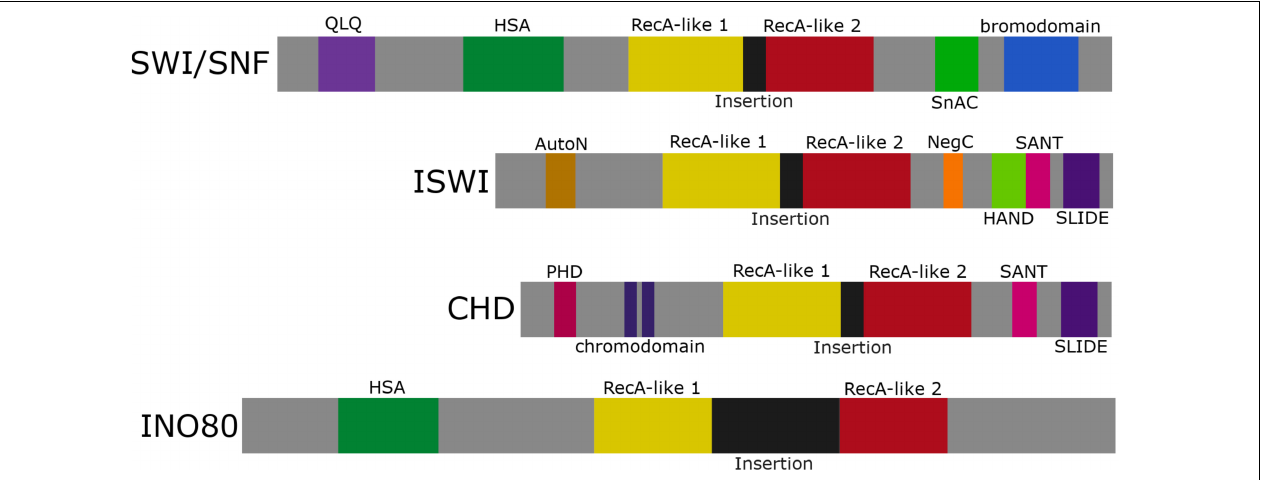
FIGURE 1 | The ATP-dependent chromatin remodeling family. Representation of the four chromatin remodeling groups: SWI/SNF, ISWI, CHD, and INO80. Each group contains an ATPase domain subdivided into RecA-like lobes 1 and 2 separated by a variable linker region (labeled insertion). SWI/SNF and INO80 share an HSA domain, while ISWI and CHD share a SANT and SLIDE